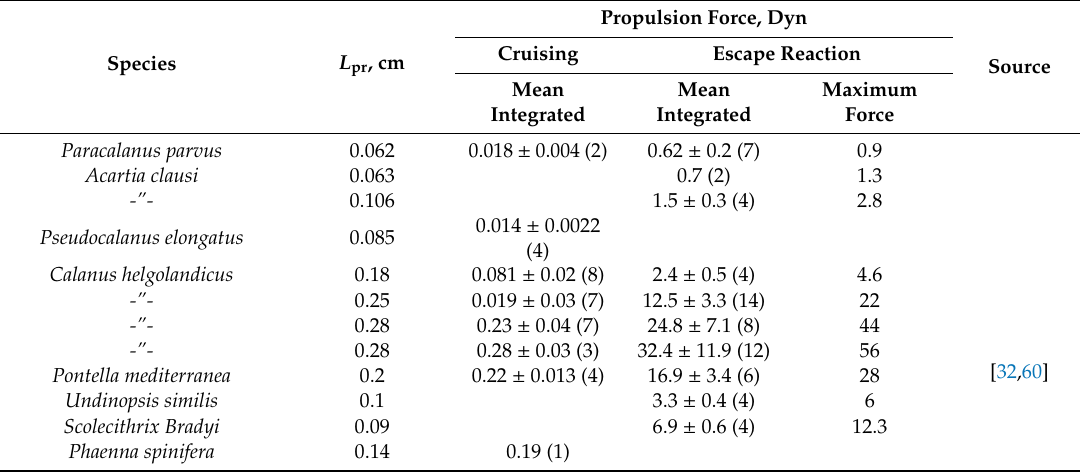
Table 4. Propulsive forces created by cephalic limbs during cruising and by thoracic legs at escape reaction in copepods attached to force sensor. The number of individuals is shown in parenthesis.